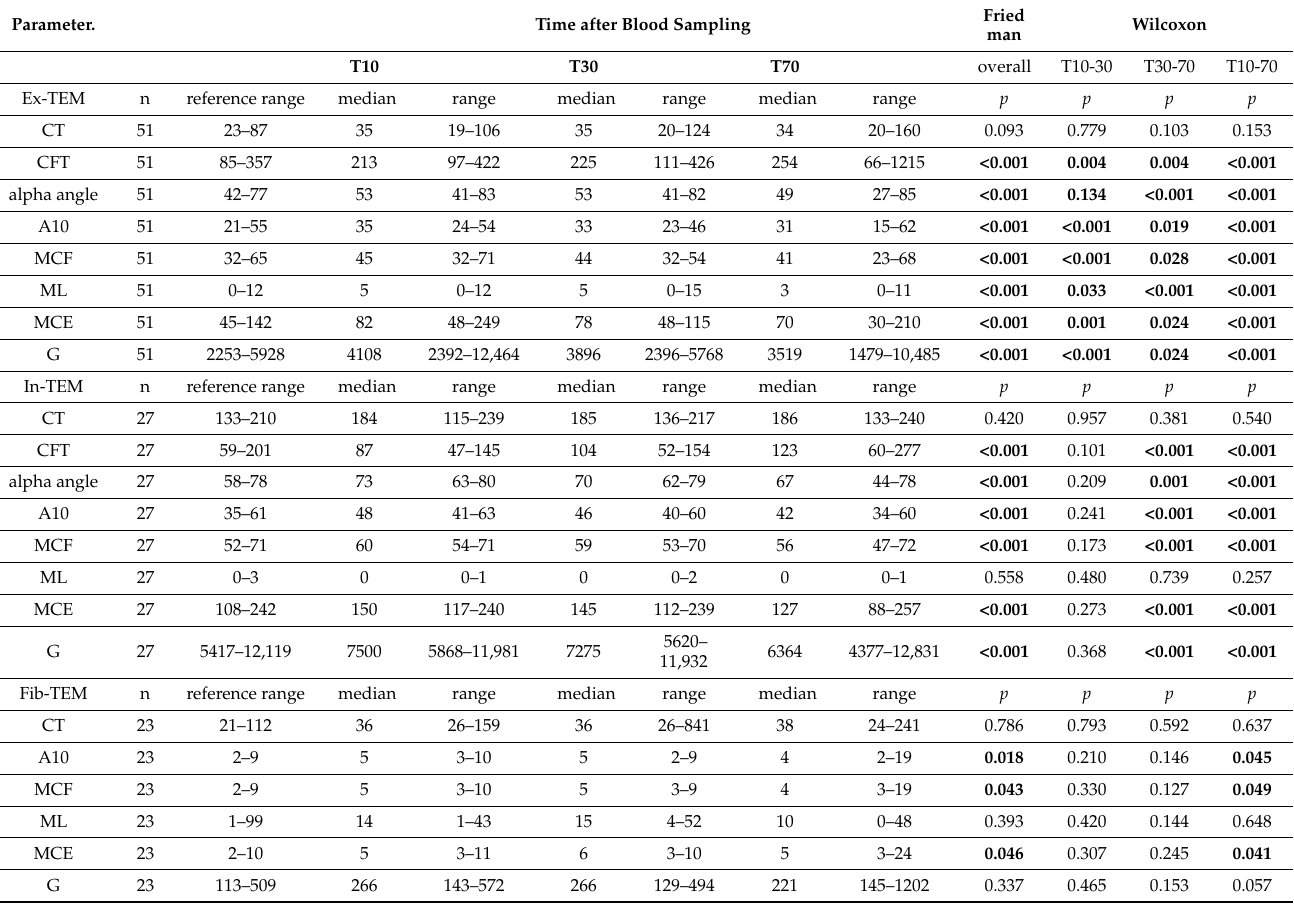
Table 2. Normocoagulable tracings of Ex-TEM, In-TEM, and Fib-TEM over